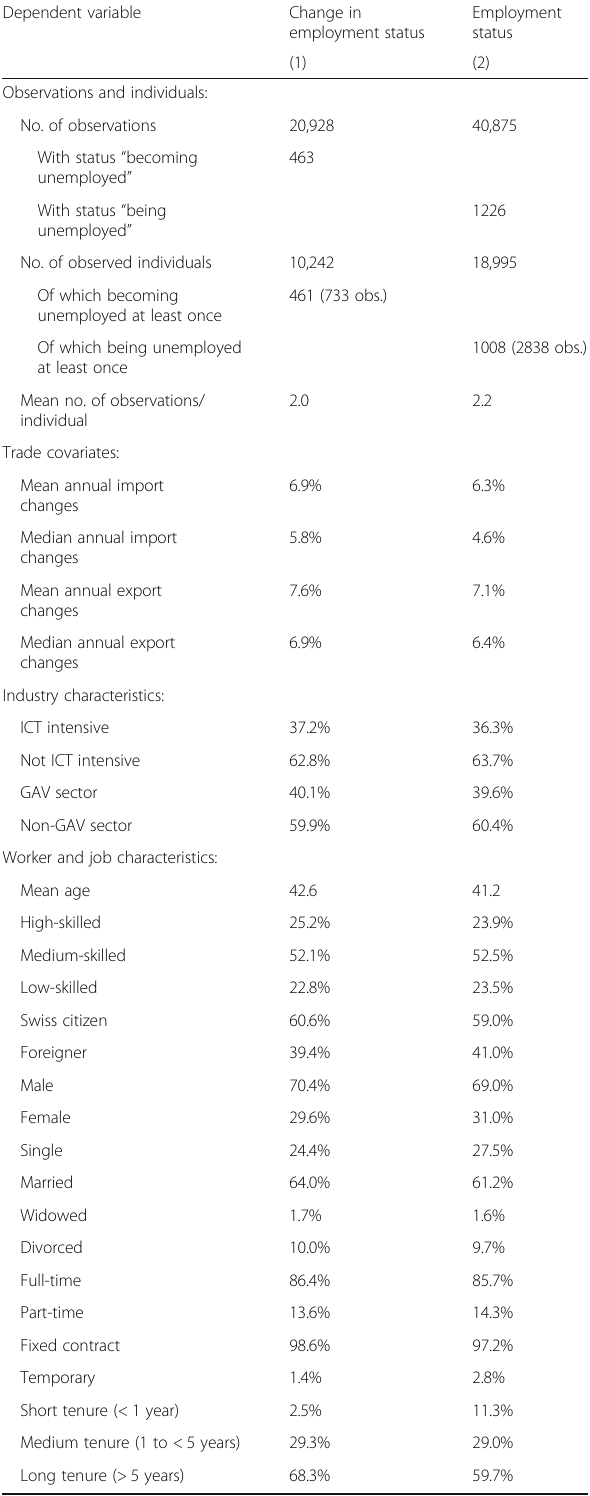
Table 1 Summary statistics of the regression data set Dependent